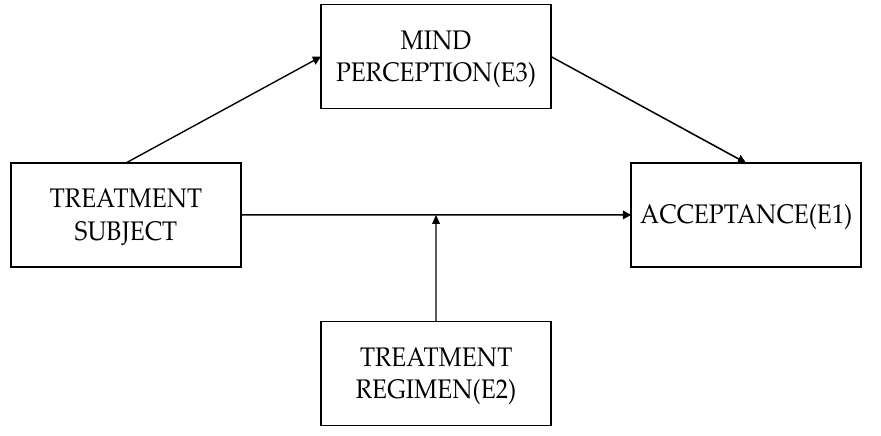
Figure 1. Research framework.